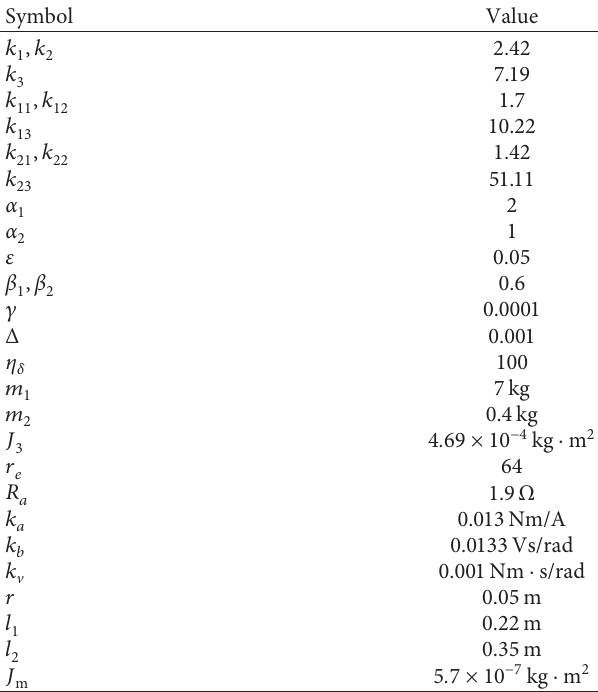
Table 1: Related parameters.